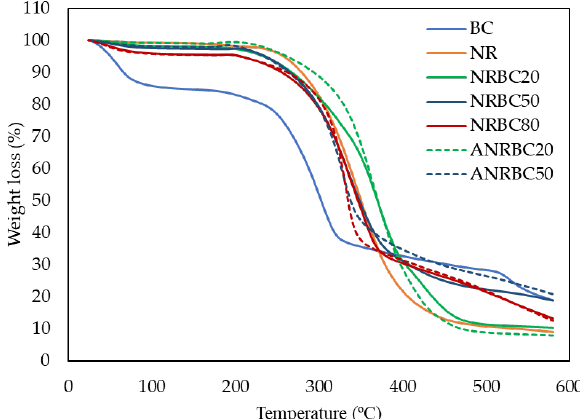
Figure 6. Weight loss of NR, BC, and NRBC composites . Table 2. Thermal properties of NR, BC, NRBC, and ANRBC films.